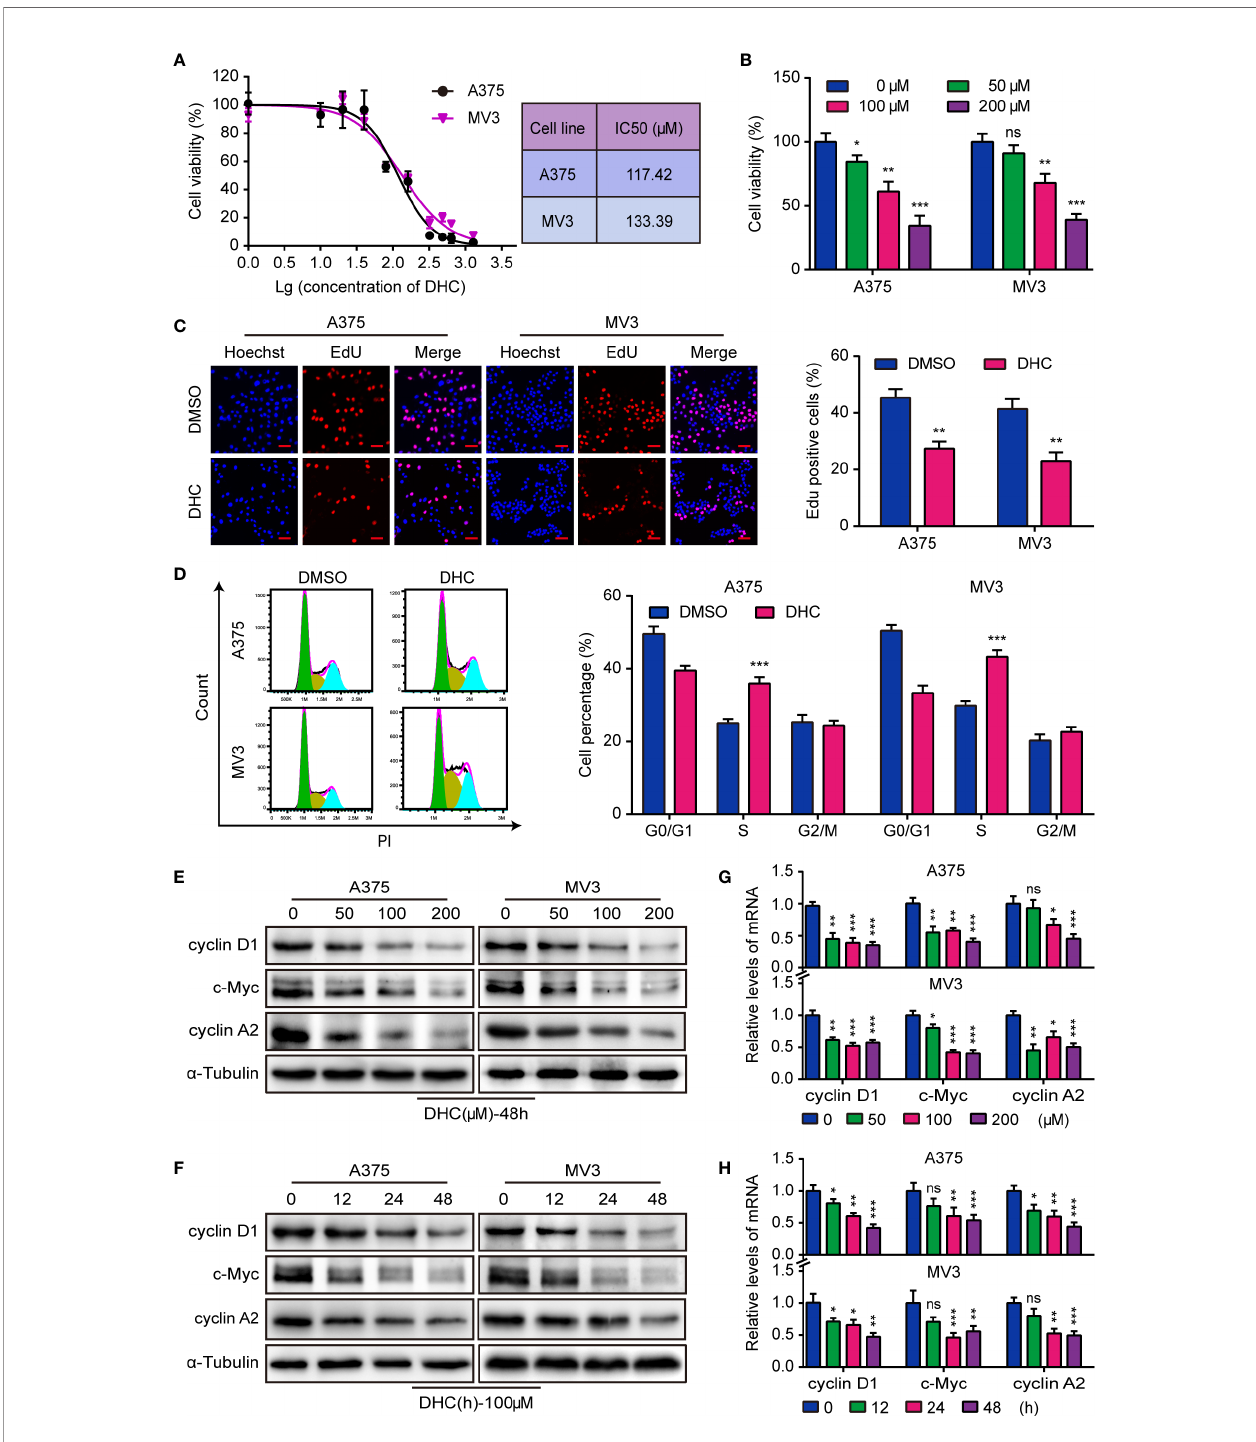
FIGURE 1 | DHC shows anti-proliferation activity in melanoma cells. (A) The IC50 of DHC for A375 and MV3 cells was measured. (B) Cell viabilities of A375 and MV3 cells treated with DHC (0, 50, 100, and 200 m M) for 48 h. (C) EdU staining of A375 and MV3 cells treated with 100 m M DHC for 48 h. Scale bar, 50 m m. (D) Cell cycle analysis of A375 and MV3 cells treated with 100 m M DHC for 48 h. (E, G) The protein and mRNA levels of cyclin D1, c-Myc, and cyclin A2 in A375 and MV3 cells treated with 0, 50, 100, and 200 m M DHC for 48 h. (F, H) The protein and mRNA levels of cyclin D1, c-Myc, and cyclin A2 in A375 and MV3 cells treated with 100 m M DHC for 0, 12, 24, and 48 h. * P <0.05; ** P <0.01; *** P < 0.001; ns, not signi fi